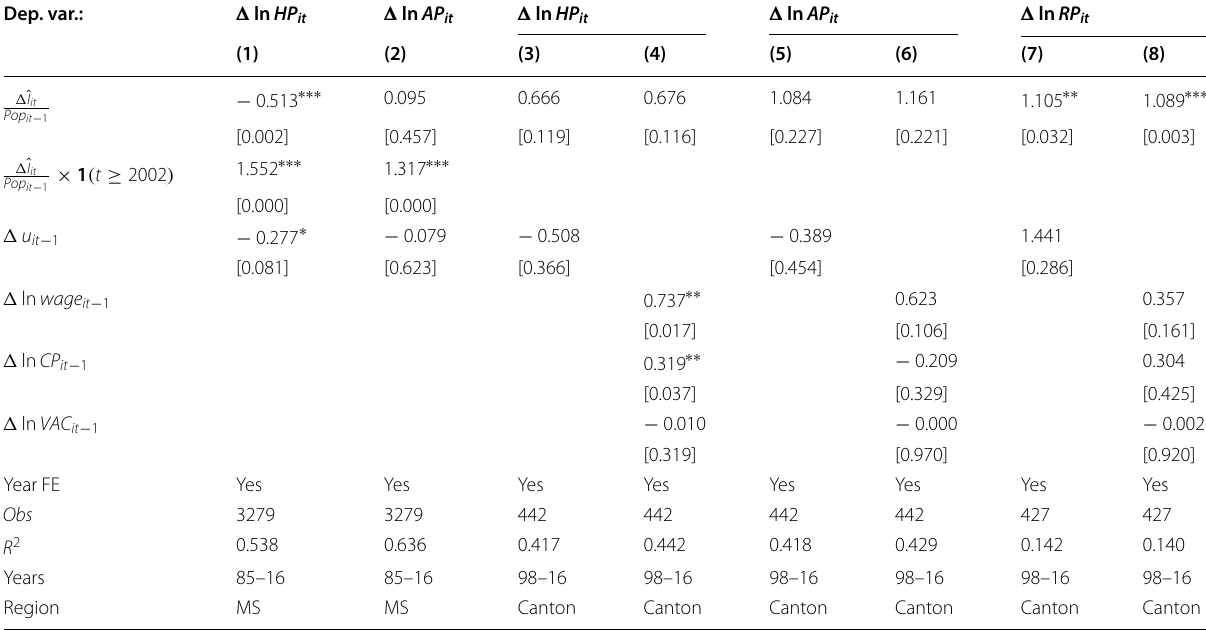
Table 12 Housing prices and immigration: reduced-form regressions. Source: Own calculations based on data from Wüest Partner and Federal Statistical